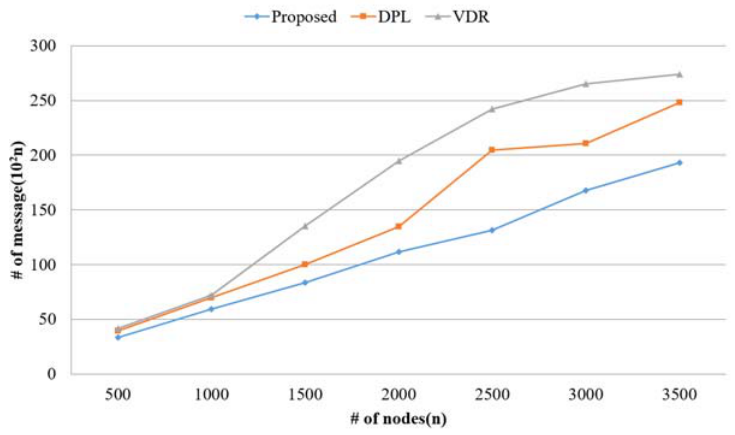
Figure 8. Number of messages generated according to the number of nodes.